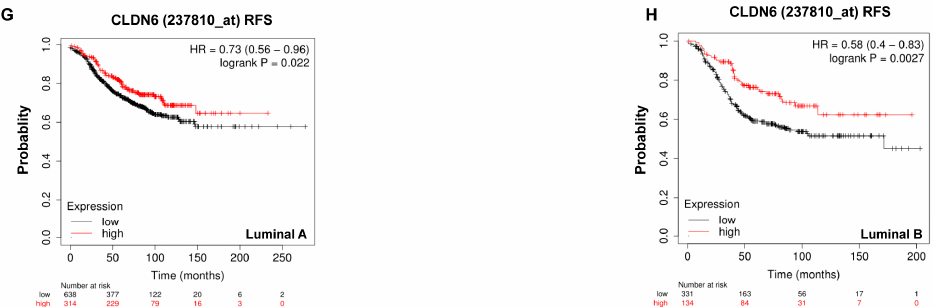
Figure 1. Expression of CLDN6 in breast cancer tissues and its relationship with patient prognosis. ( A ) The mRNA expression of CLDN6 in adjacent normal and breast cancer tissues in the GEO database GSE134359. *** p < 0.001. ( B ) Representative graphs of CLDN6 IHC staining for high and low expression in TMA. Scale bar, 50 µ m. ( C ) Analysis of the staining intensity score of CLDN6 in TMA. * p < 0.05. ( D ) The relationship between CLDN6 expression and RFS in 2032 breast cancer patients analyzed by Kaplan–Meier plotter. Kaplan–Meier survival curves of CLDN6 expression and RFS in basal–like ( E ), HER2+ ( F ), luminal A ( G ), and luminal B ( H ) breast cancer patients.